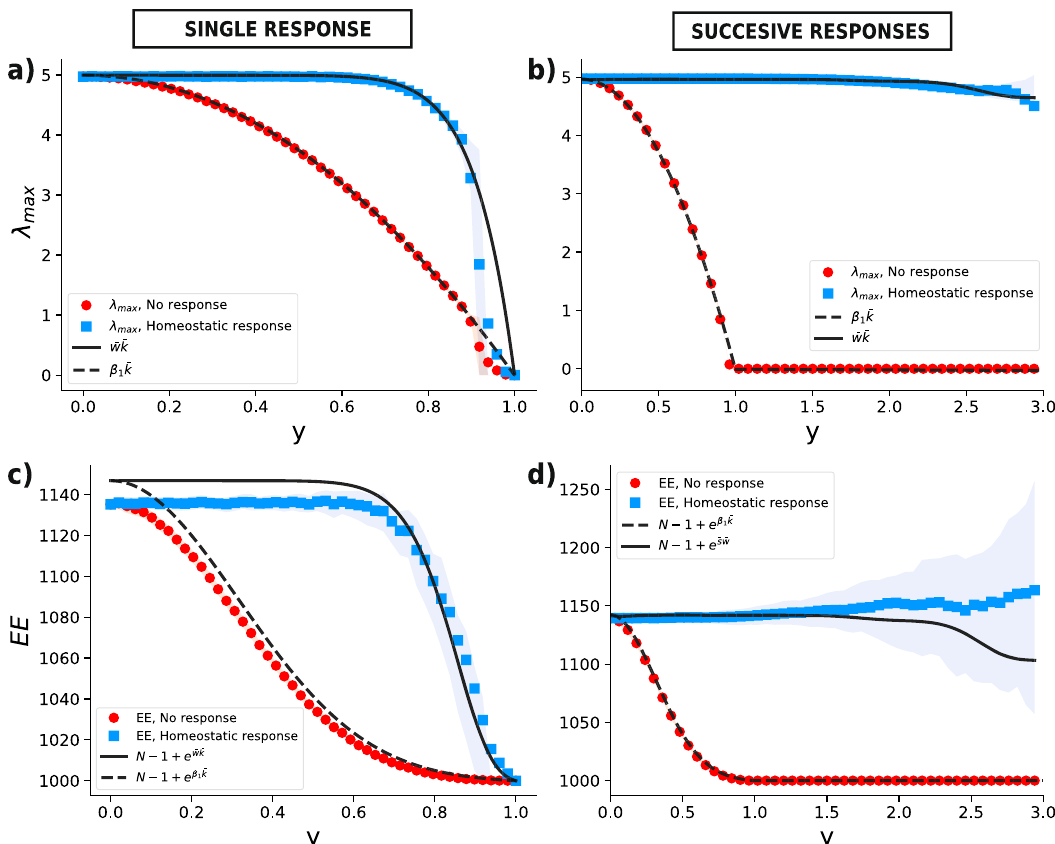
Fig. 5 Leading eigenvalue and Estrada index for both single and multiple instances of the damage-response process. Continuous and dashed black lines represent the values from our model in the case of homeostatic response and no response respectively, while colored markers and colored shaded areas represent mean values and interquartile ranges derived from stochastic simulations. We averaged the damage-response process over 200 realizations of a random regular network of N = 10 3 nodes and average degree z = 10 with uniform weights. a , c Single instances of the damage – response process. In this case (cid:1) w (cid:1) k is simply given by combining Eqs. (3) and (6). b , d Successive instances of the damage – response process. Here, both (cid:1) w and (cid:1) k are computed at each step from the master equation (1). In every panel, β 1 is computed from Eq.